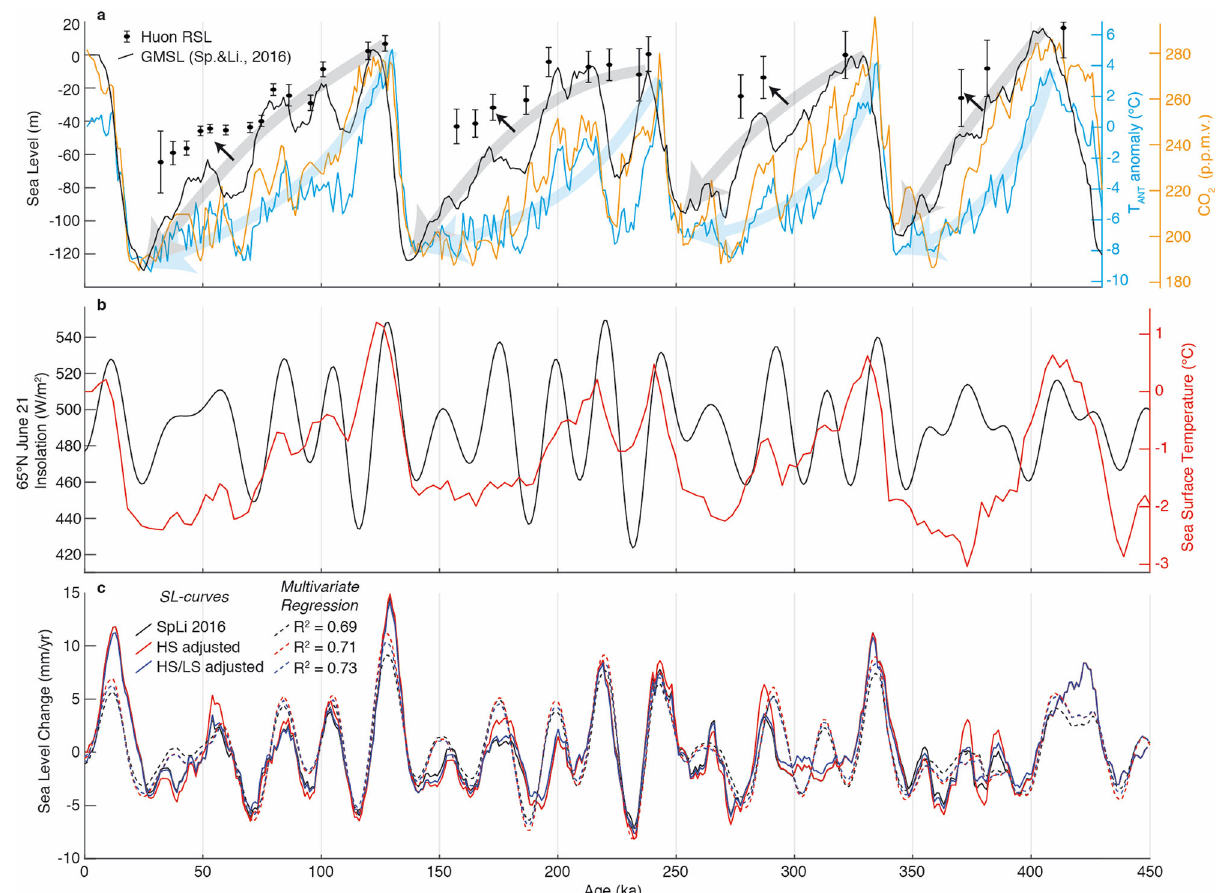
Fig. 5 Comparison paleo sea-level and paleo climate data. a Comparison of GMSL 4 , Huon RSL, temperature 89 and CO 2 90 . Temperature anomaly and CO 2 record are both derived from Antarctic EPICA Dome C ice cores. Vertical axes are scaled to the maximum and minimum of each record within the last glacial cycle (~130 ka - present). Transparent arrows illustrate approximate trends in temperature and GMSL per glacial cycle, solid arrows illustrate the stronger non-linearity in GMSL as suggested by Huon RSL constraints. Error bars for Huon RSL data points indicate Standard Errors (see Methods). b Insolation variations at 65° N on June 21 91 and sea-surface temperature variations from a global stack 67 . c Rate of change of the sea-level curves in a , calculated over a running 6-kyr window and scaled to a multivariate regression model (as in previous work 67 ) based on the summer insolation and global sea-surface temperatures in b , and sea-level curves in a